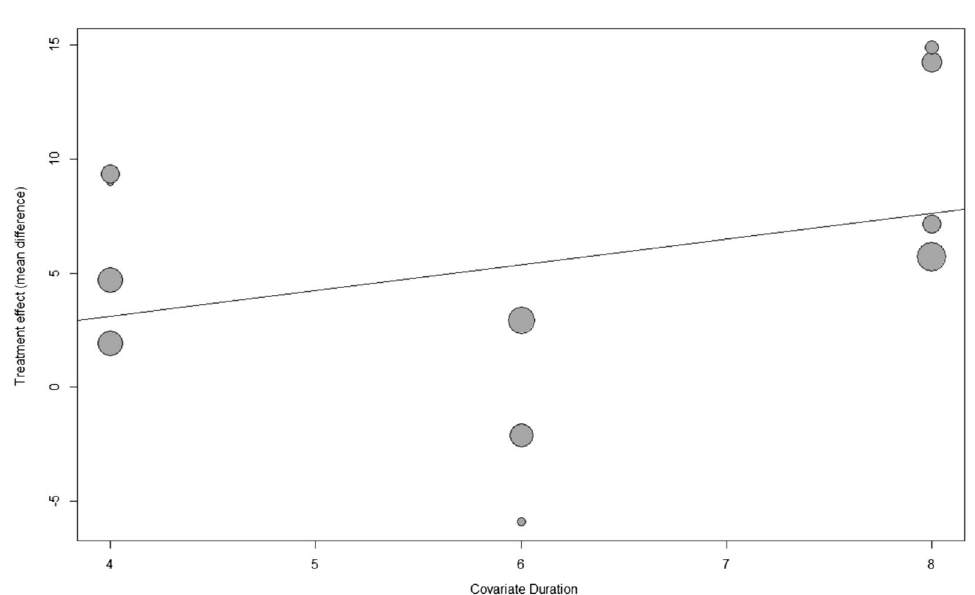
Figure 4. Meta-regression bubble plot of the correlation between effect of tongue strengthening exercise on anterior tongue strength and the duration of intervention. Each bubble represents a study and bubble size represents the sample size of the